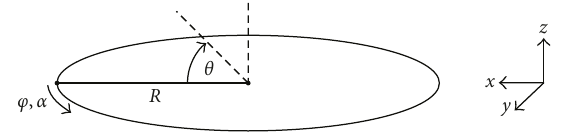
Figure 1: Geometry and variables of the circular array.